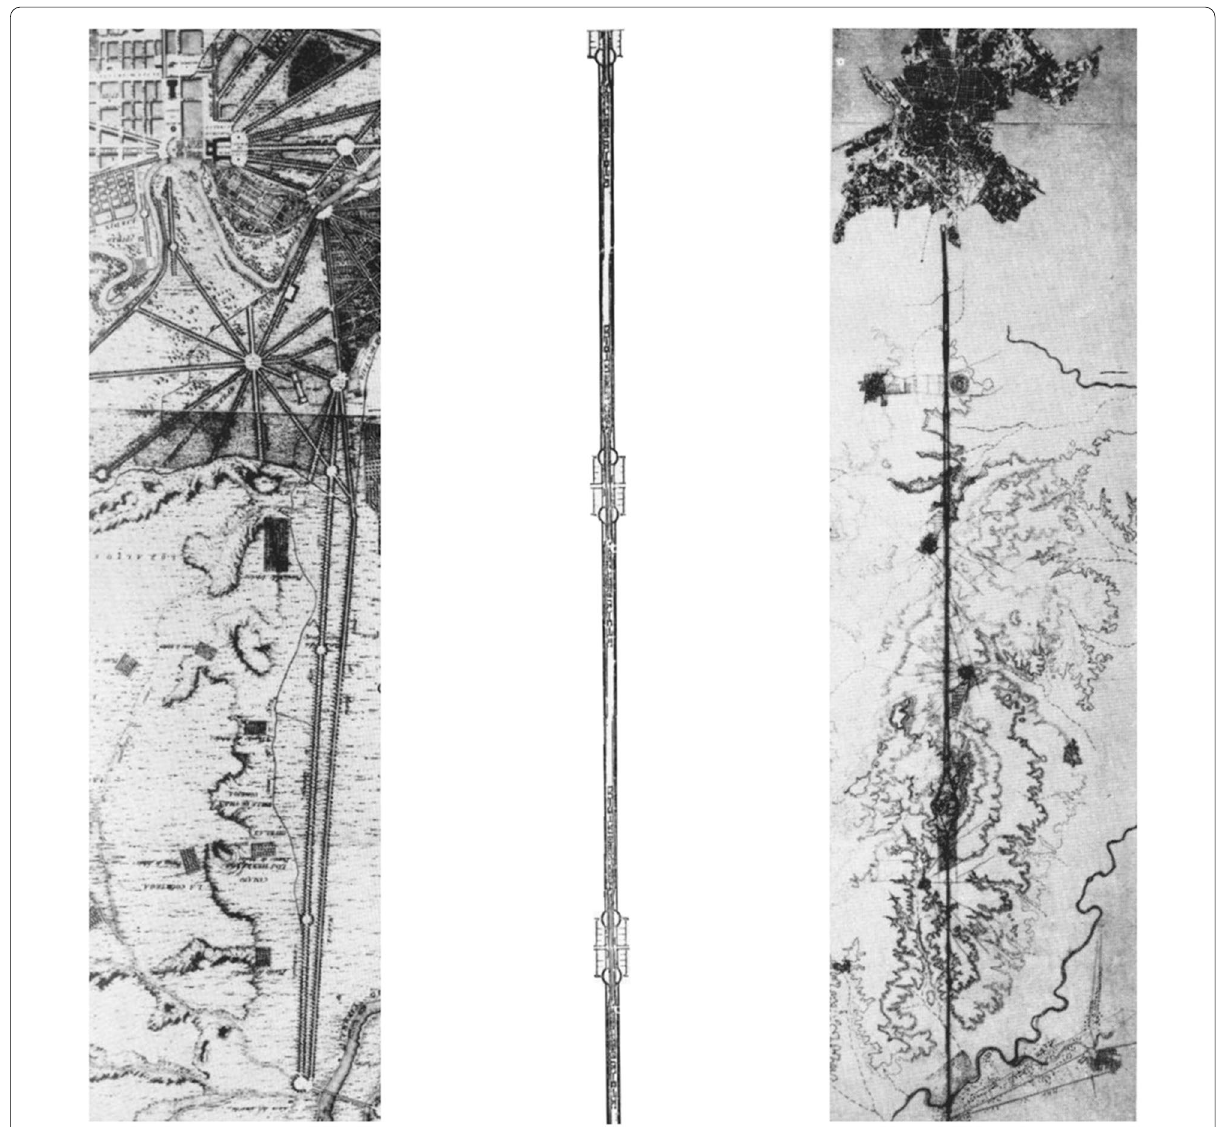
Fig. 4 Solà-Morales. Project for the Madrid-Aranjuez highway. 1978. Source: Solà-Morales M (1978) The Architecture of the Territory. In: Vidler A et al. (ed) Rational Architecture: The Reconstruction of the European City. Bruxelles: Éditions des Archives d’Architecture